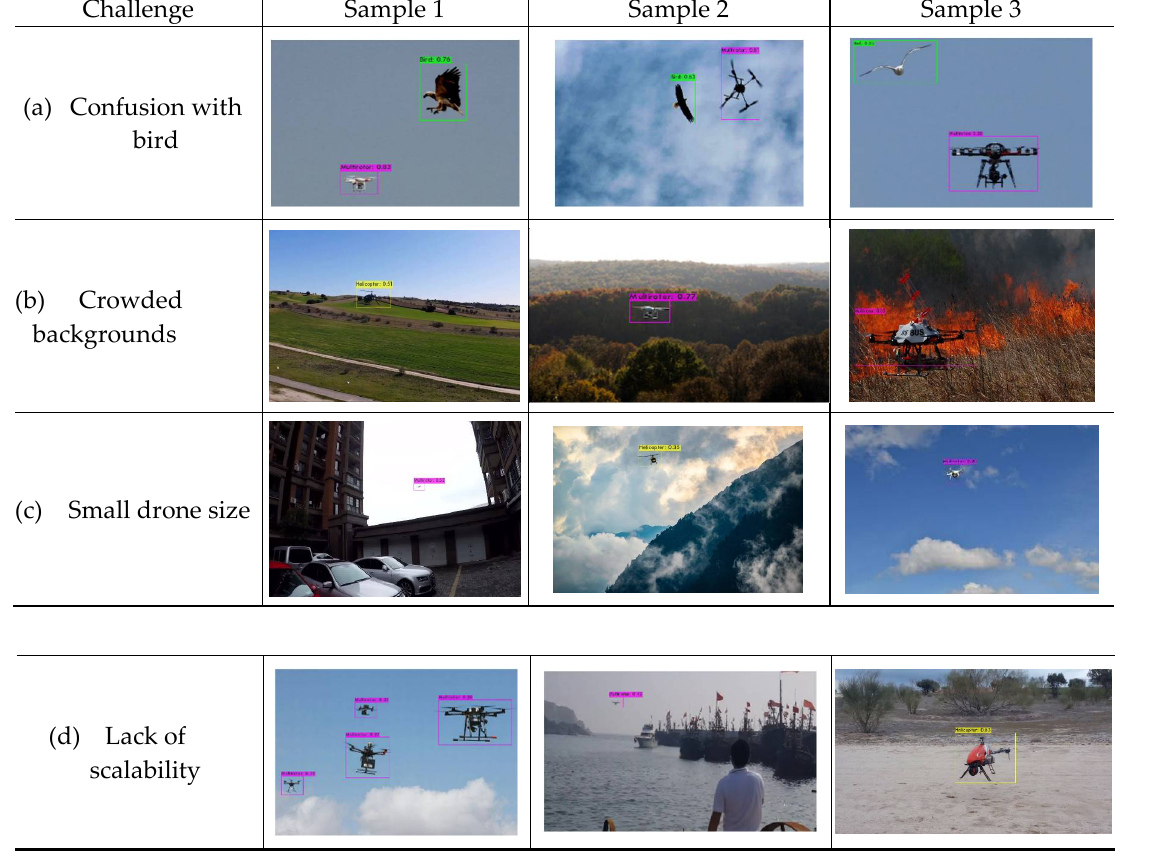
Figure 17. Some samples of solving a variety of challenges in drone detection.